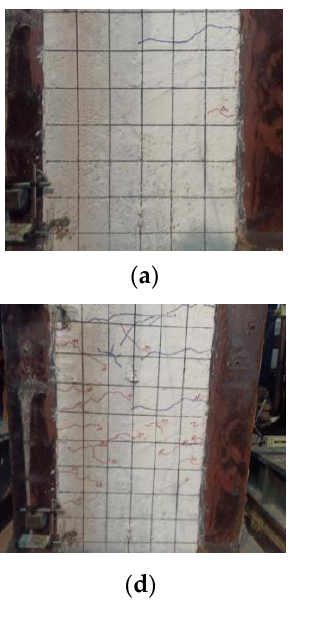
Figure 13. Failure patterns of specimens. ( a ) SW1; ( b ) SW2; ( c ) SW3; ( d ) SW4.